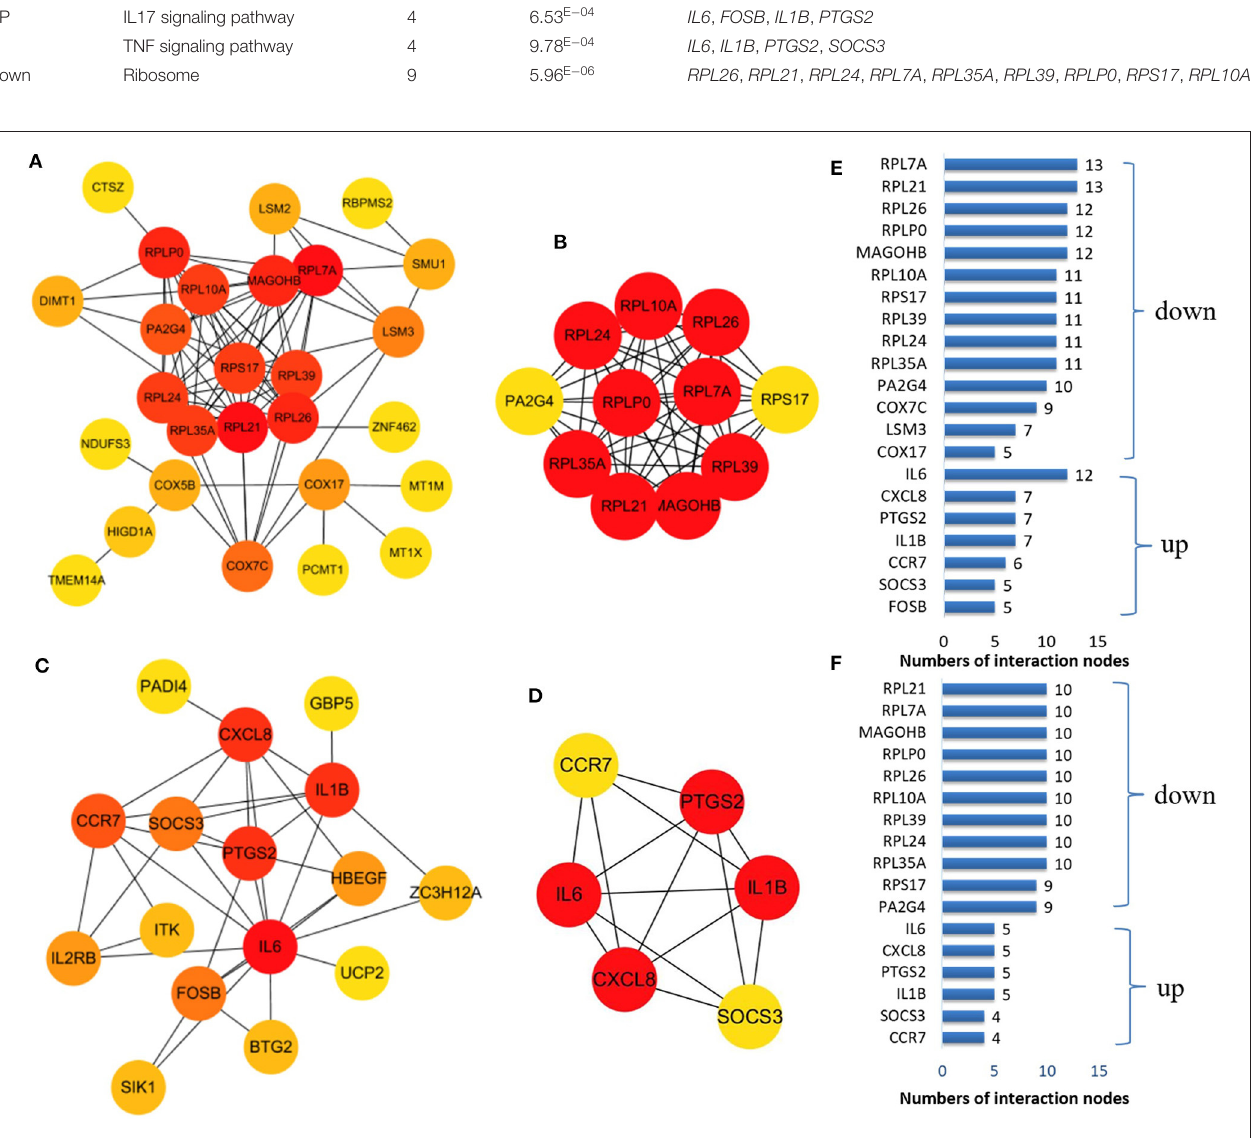
FIGURE 5 | The protein–protein interaction (PPI) network constructed via the STRING database for the DEP with the colors of nodes representing the degree of gene interaction. PPI network of the downregulated DEGs (A) and the upregulated DEGs (C) identified from GSE47472 and GSE57691. The sub-networks were identified by Cytoscape MCODE plug-in [ (B) , upregulated; (D) , downregulated]. (E) Genes from the upregulated and downregulated DEGs based on the PPI network analysis with the degree of interaction in the PPI network. (F) Genes from the two sub-networks with the degree of interaction in the PPI